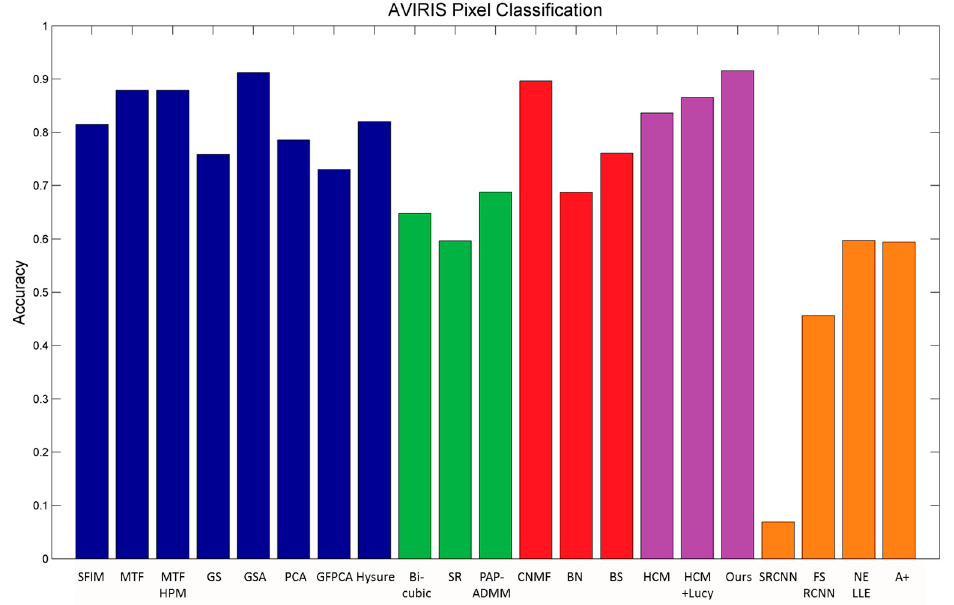
Figure 8. Clustering accuracy using different algorithms for the AVIRIS dataset. Red: Group 1 methods; Blue: Group 2 methods; Green: Single image super-resolution methods; Purple: HCM methods; Orange: Deep learning and dictionary based methods.